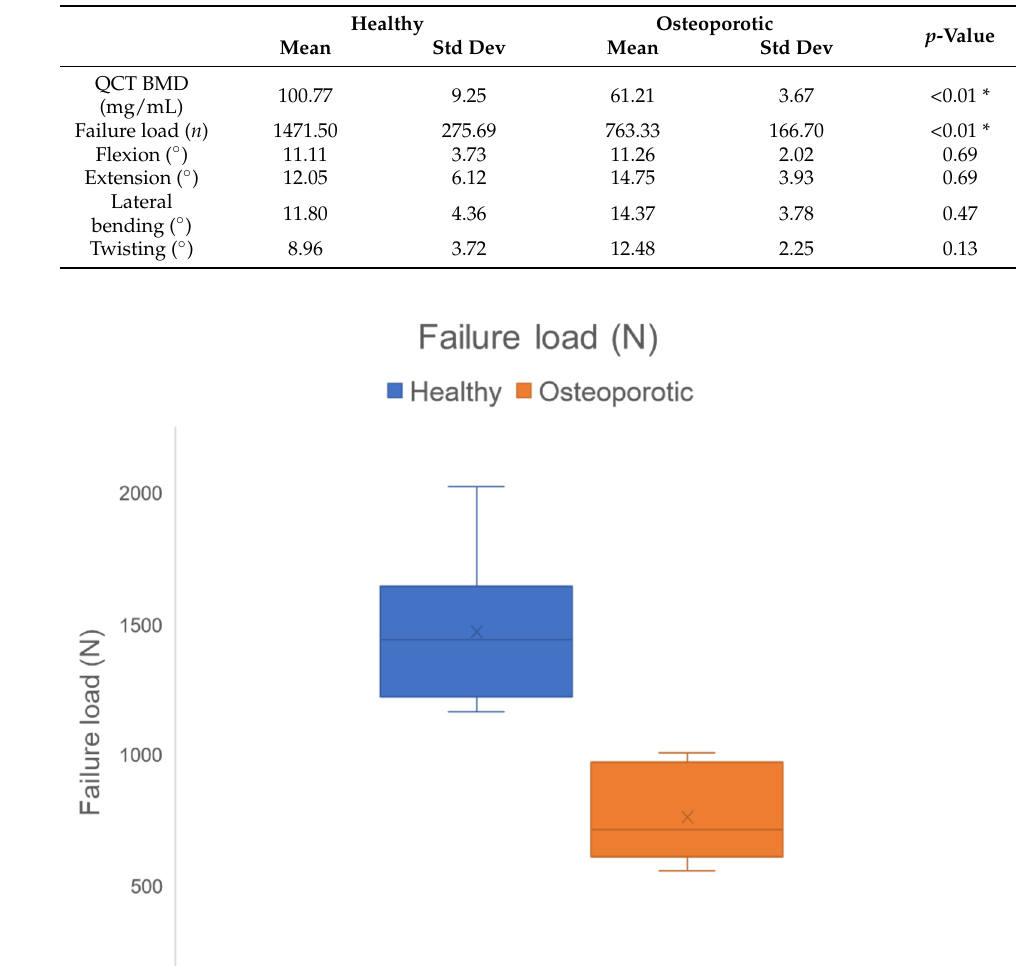
Table 3. Comparison of BMD, failure load, and ROM parameters for healthy and osteoporotic subjects and level of significance values. The asterisks (*) indicate statistical significance (p < 0.01).